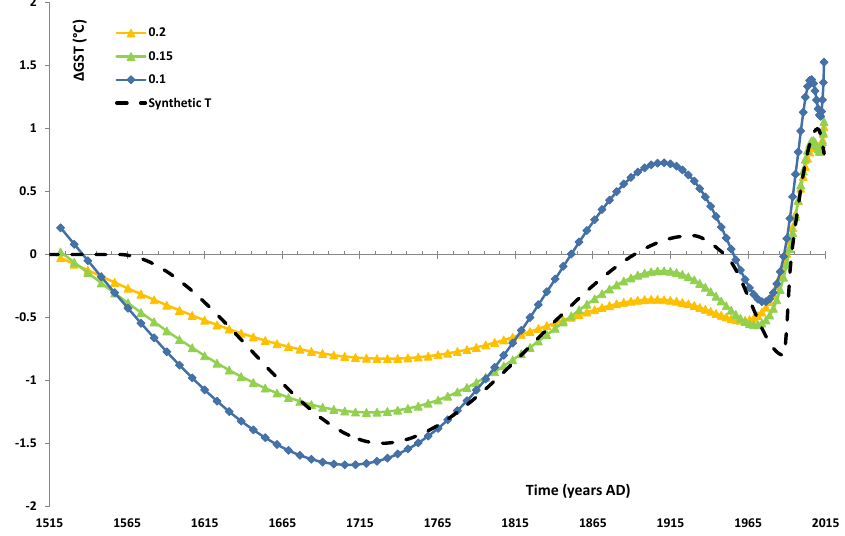
Figure 4. Synthetic data for the present time. It is remarkable that by also varying the α value by 33%, the reconstructed GST does not vary significantly. Legend: 0.1: blue line; 0.15: green line; 0.2: orange